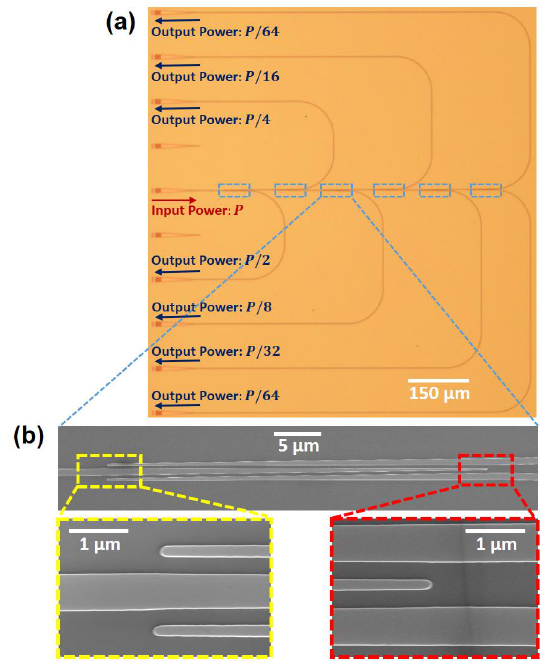
Figure 5. (a) Cascaded six-stage structure for excess loss measurement. (b) Scanning electron Figure 5. ( a ) Cascaded six-stage structure for excess loss measurement. ( b ) Scanning electron microscope microscope (SEM) images of fabricated optical power splitter. (SEM) images of fabricated optical power